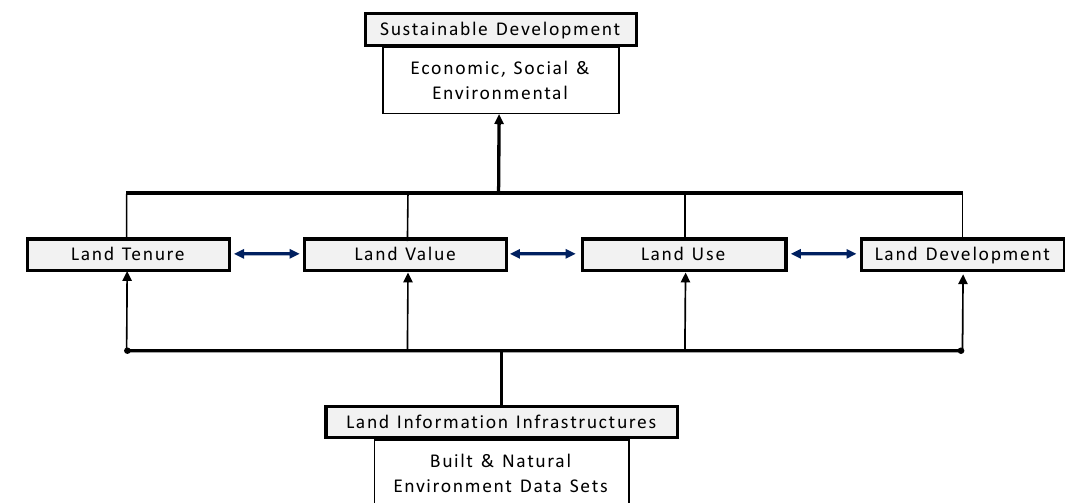
Figure 3. A Global Land Administration Perspective ([48], adapted].